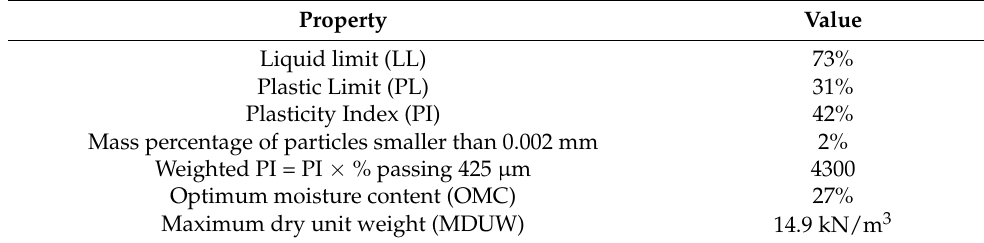
Table 1. Summary of the soil properties